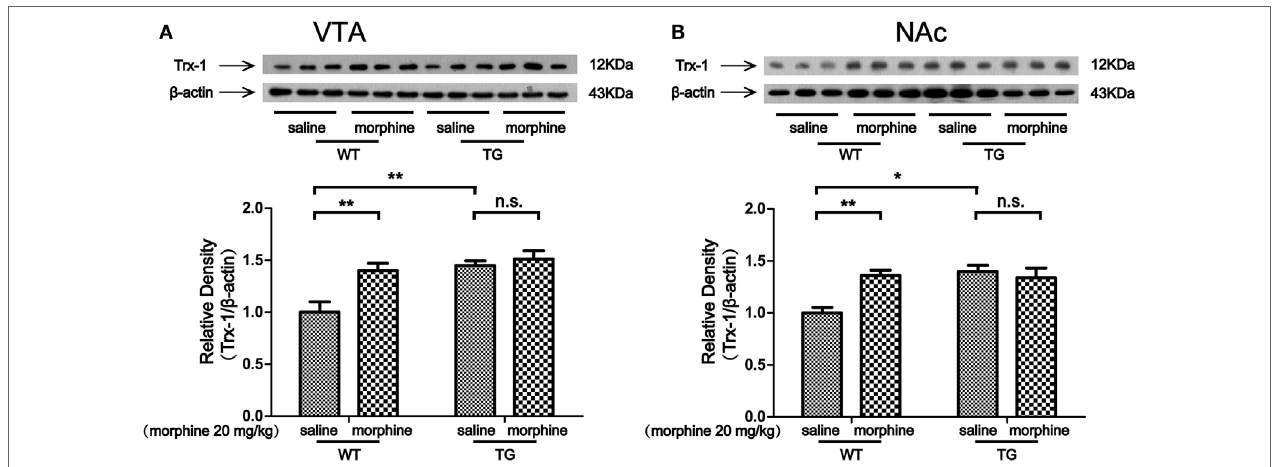
FigUre 3 | Thioredoxin-1 (Trx-1) expression in the ventral tegmental area (VTA) and nucleus accumbens (NAc). Immediately after the post-conditioning test, the VTA and NAc of mice were dissected out. Trx-1 expression was detected by western blot analysis. Trx-1 overexpression inhibited the further increase of Trx-1 by morphine in the VTA (a) and NAc (B) . Each bar represents the mean ± SE ( n = 6). n.s. > 0.05, * P < 0.05 and ** P < 0.01, statistically